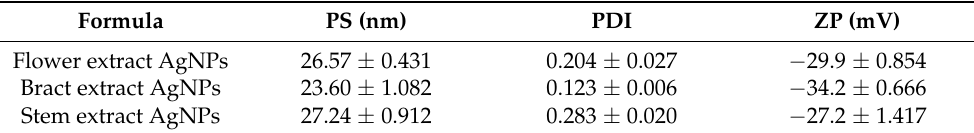
Table 2. Particle size (PS), polydispersity index (PDI), and zeta potential (ZP) of the synthesized AgNPs. Formula PS (nm) PDI ZP (mV) Flower extract AgNPs 26.57 ± 0.431 0.204 ± 0.027 − 29.9 ± 0.854 Bract extract AgNPs 23.60 ±